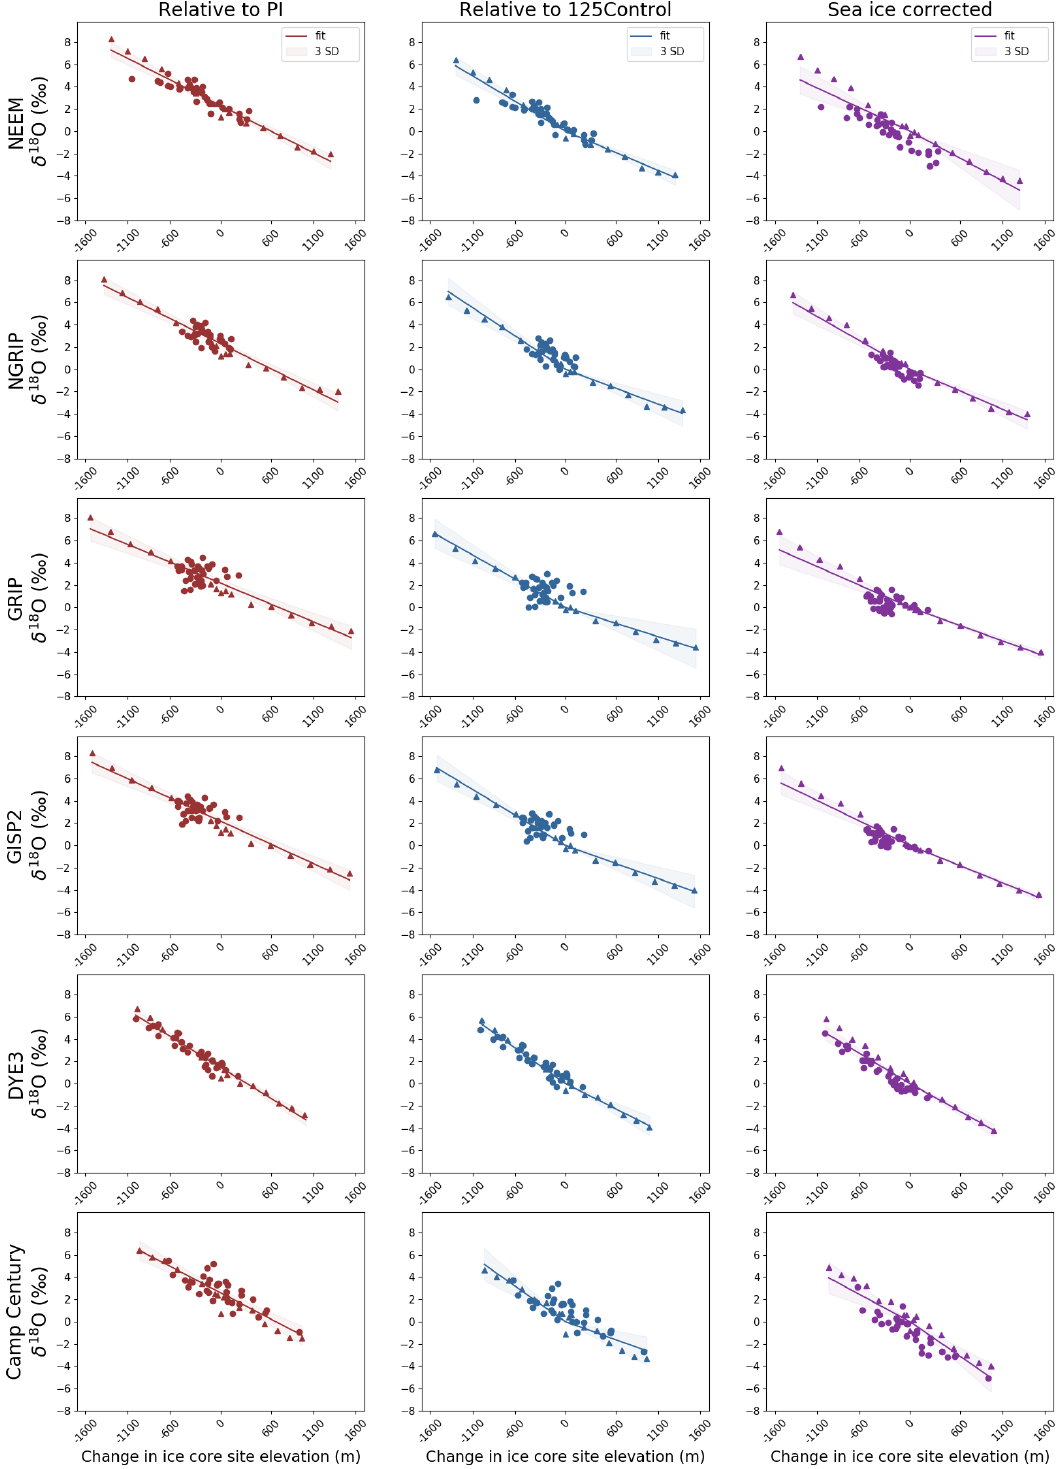
Figure 7. δ 18 O p anomalies as a function of ice core site elevation change (m) relative to PI (first column) and 125Control (second column). Also shown are sea-ice-corrected δ 18 O p anomalies compared to 125Control (third row). Ice core sites displayed: NEEM (first row), NGRIP (second row), GRIP (third row), GISP2 (fourth row), DYE3 (fifth row) and Camp Century (sixth row). Triangles represent results for the 16 elevation change experiments. Dots represent results for the 32 simulations that examine the joined impact of Arctic sea ice retreat and modified GIS shape. Solid lines signify best fit curves (first column, y = a + bx ; second and third columns, y = ax ) and shade envelopes represent ± 3SD uncertainty on the best fit